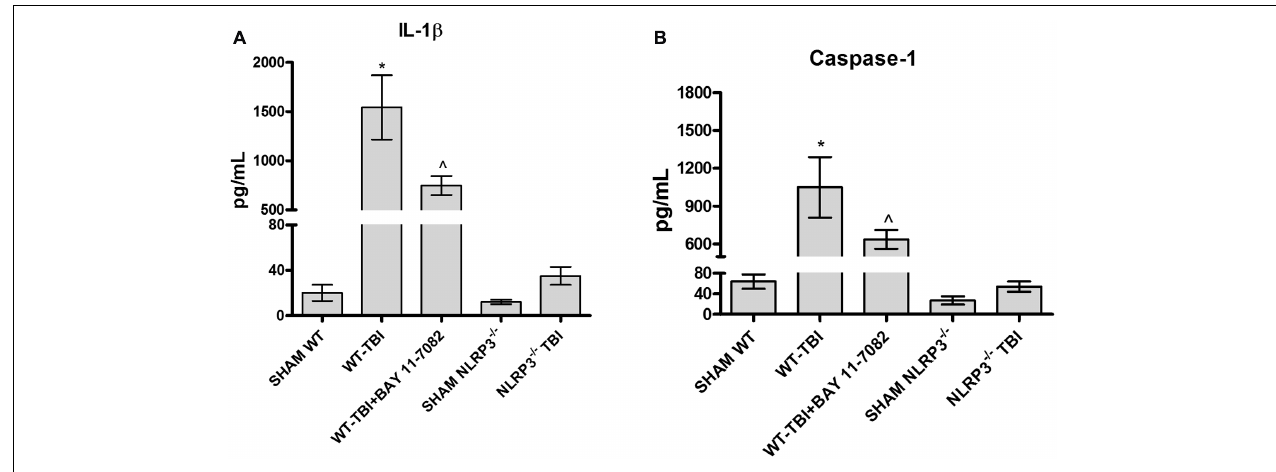
FIGURE 2 | The graph (A) represents the levels of IL-1b in brain lysates from each group of animals 24 h after TBI. The graph (B) represents the levels of caspase-1 in brain lysates from each group of animals 24 h after TBI. ∗ p < 0.05 vs Sham WT; ˆ p < 0.05 vs WT-TBI. Each bar represents the mean and SD of seven animals.